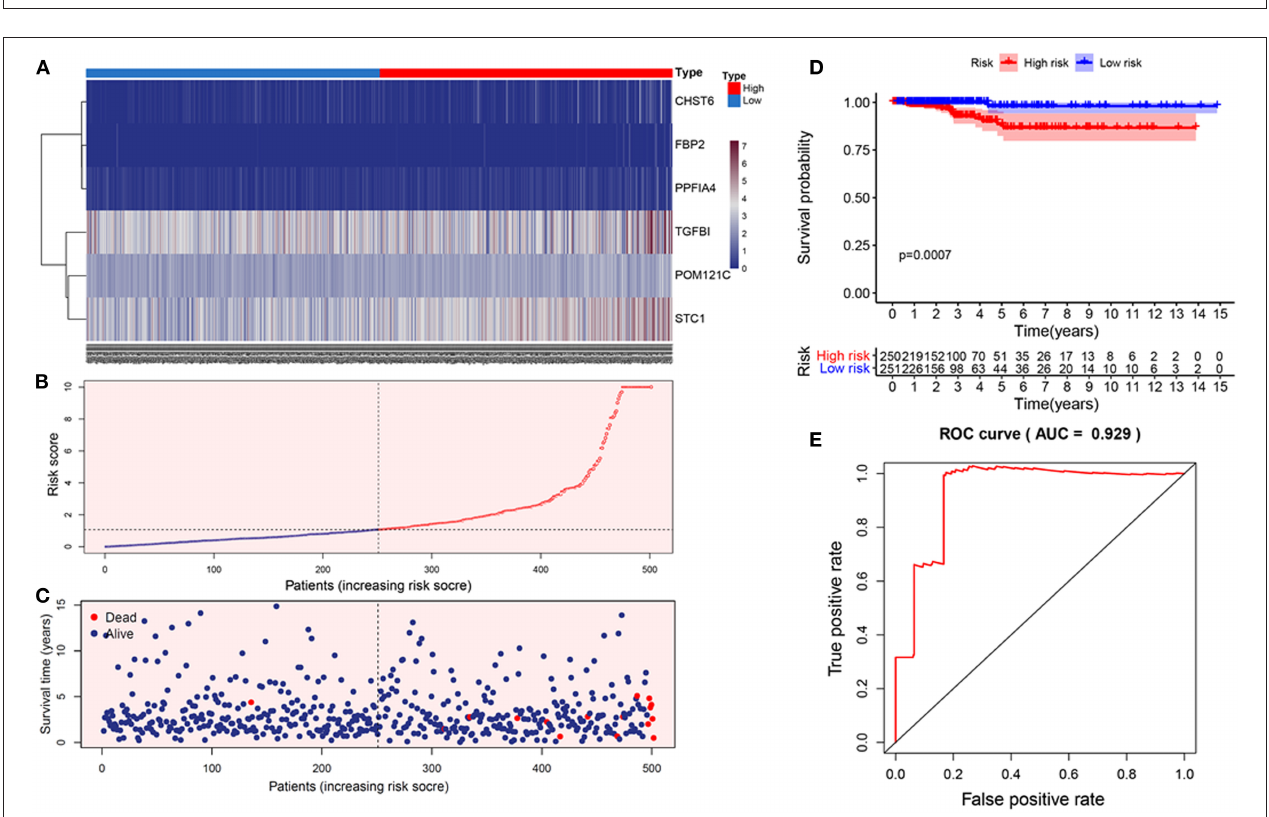
FIGURE 2 | Construction of the prognostic glycolytic gene signature in TCGA. (A) Heatmap of six-gene expression profiles between the high- and low-risk groups. (B) The distribution of the glycolysis-based risk score. (C) Vital statuses of patients between the high- and low-risk groups. (D) Kaplan-Meier survival curves of the relative overall survival of high- and low-risk patients. (E) ROC curve analysis.